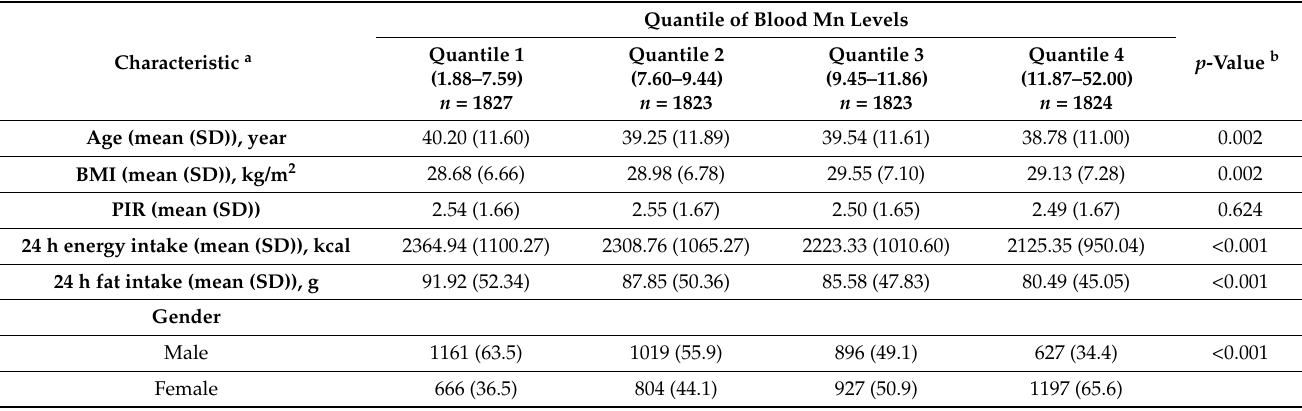
Table 1. Unweighted demographic characteristics of our study population ( n =